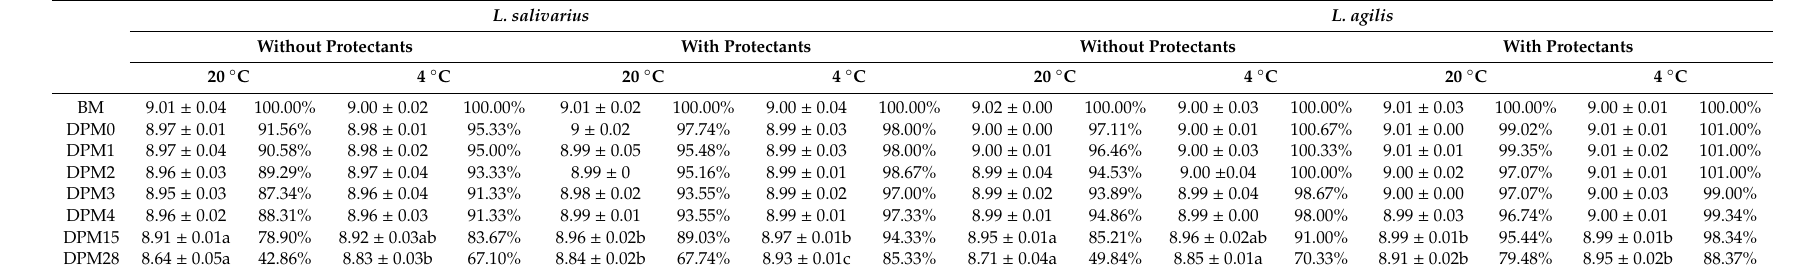
Table 4. Survival of the probiotic L. salivarius and L. agilis during the storage